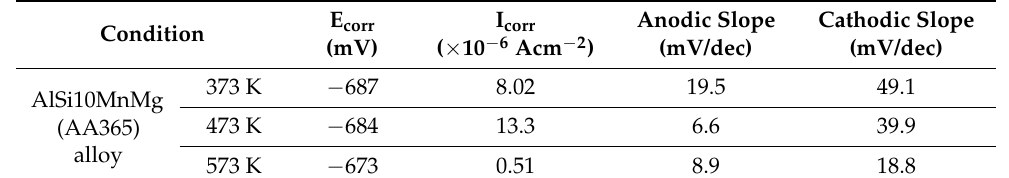
Figure 4. Cyclic potentiodynamic polarization (CPDP) curves of crept HPDC AA365 alloys in 3.5 wt.% NaCl. Table 2. Cyclic potentiodynamic polarization parameters obtained for crept HPDC AA365 alloys in 3.5 wt.% NaCl.